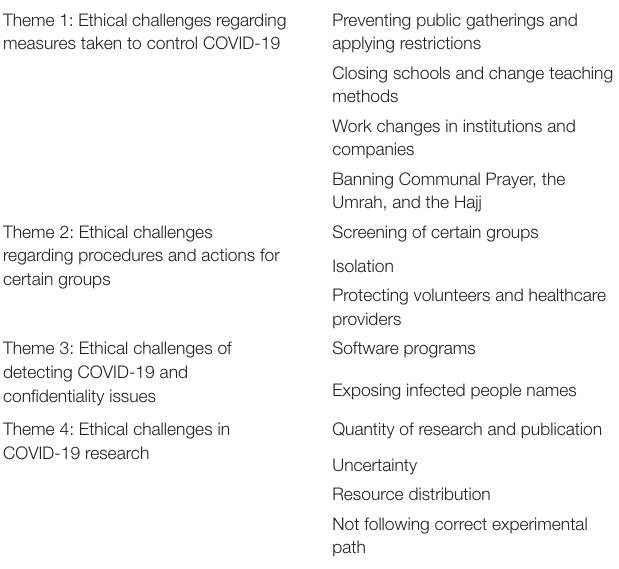
TABLE 2 | Themes and